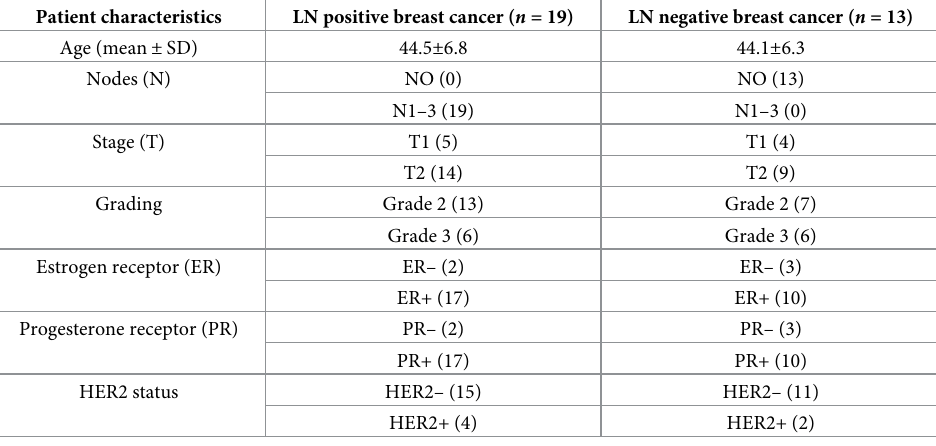
Table 1. Characteristics of patients with breast